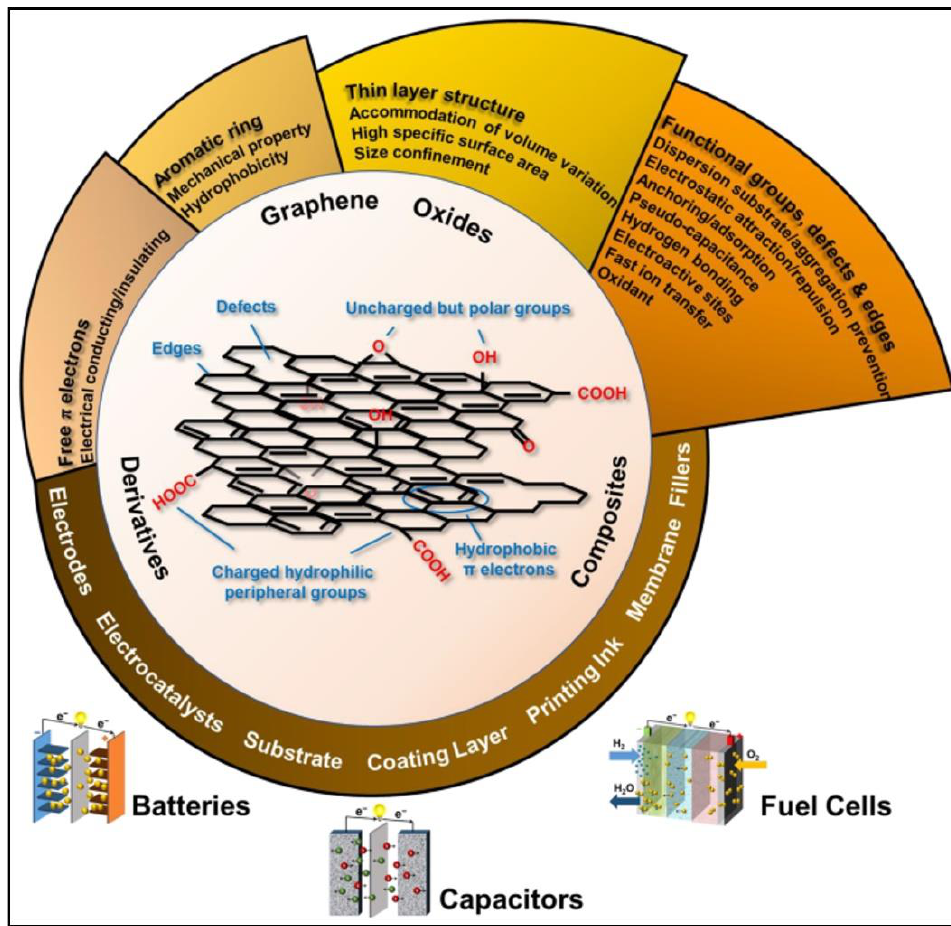
Figure 6. Graphical representation of GO based electrochemical energy storage applications. Reprinted with permission from Ref. [73].